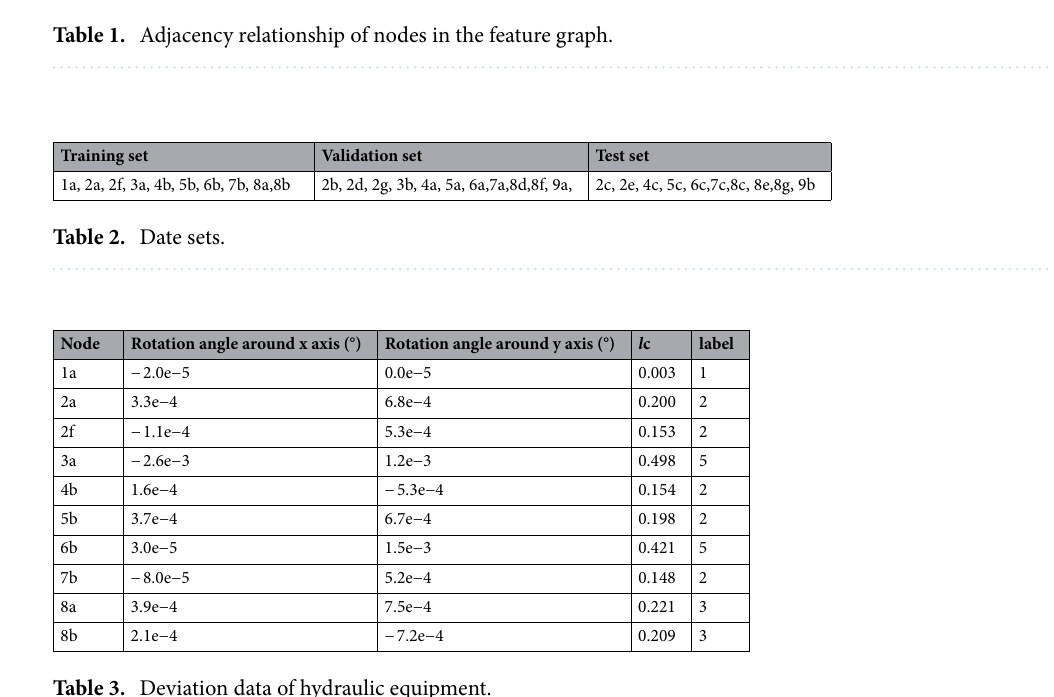
Table 3. Deviation data of hydraulic